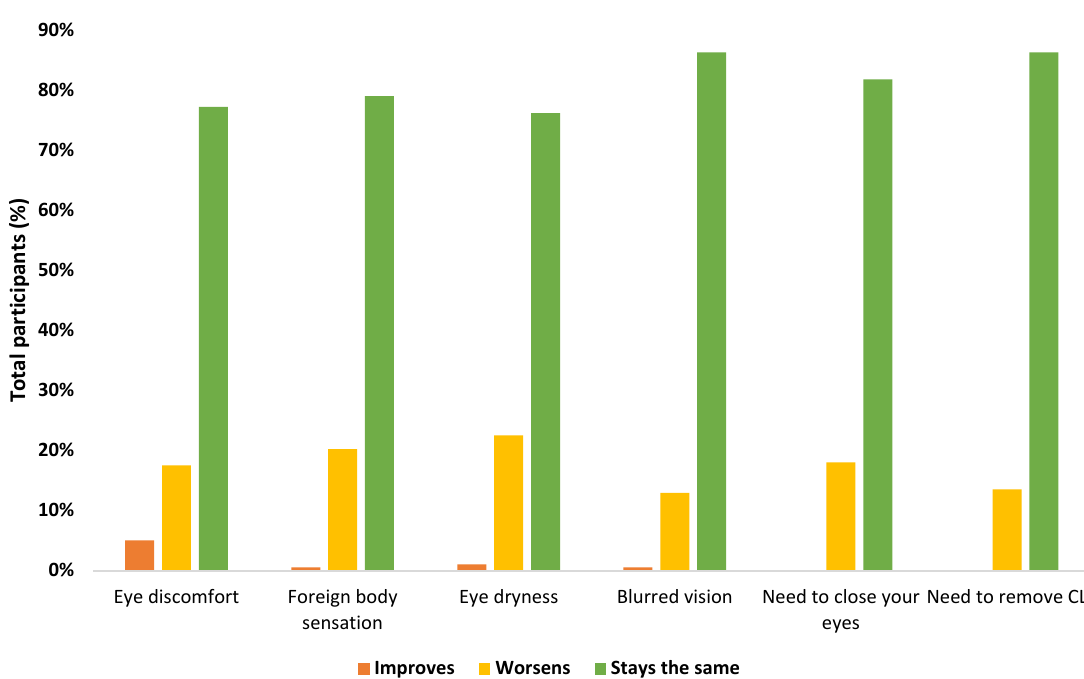
Figure 3. Presence of ocular symptoms in contact lens wearers before the pandemic.